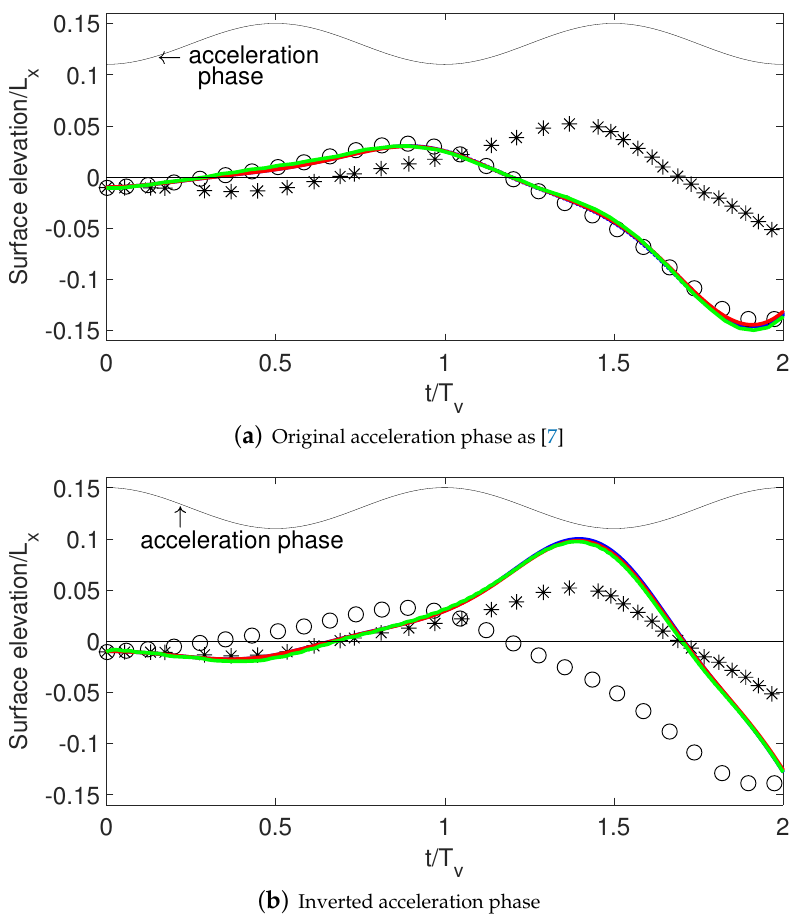
Figure 5. Initial dynamics of interface midpoint surface elevation after acceleration